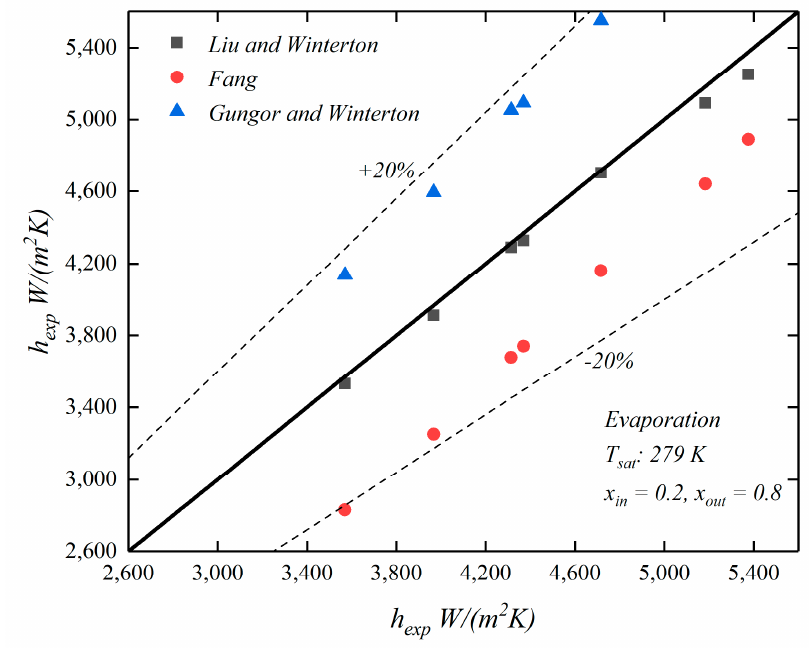
Figure 7. Comparison of evaporation correlations for use with smooth tubes.